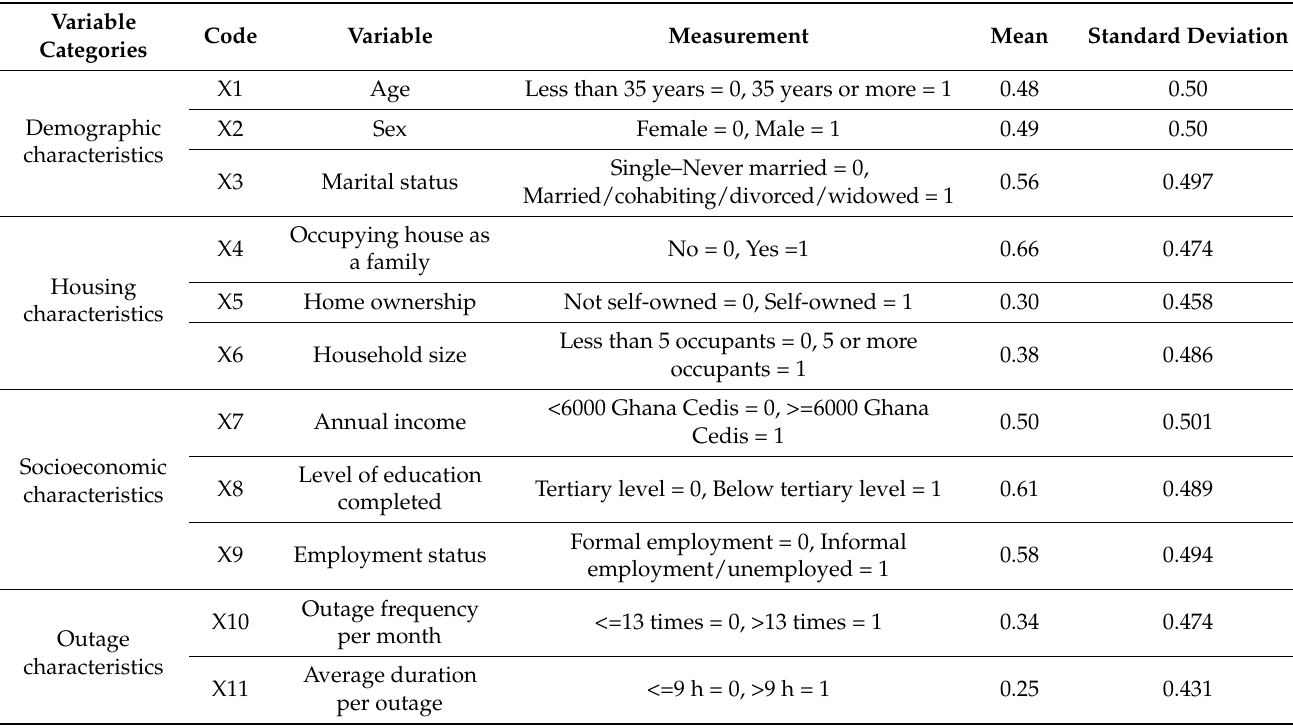
Table 3. Descriptive statistics of select household/respondent characteristics (coded as binary